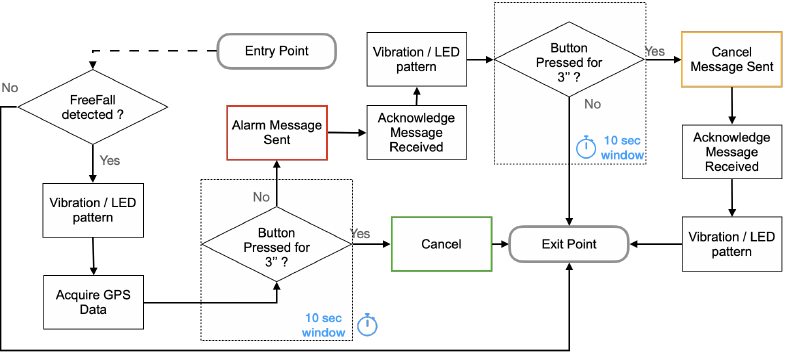
Figure 13. Free-fall check.